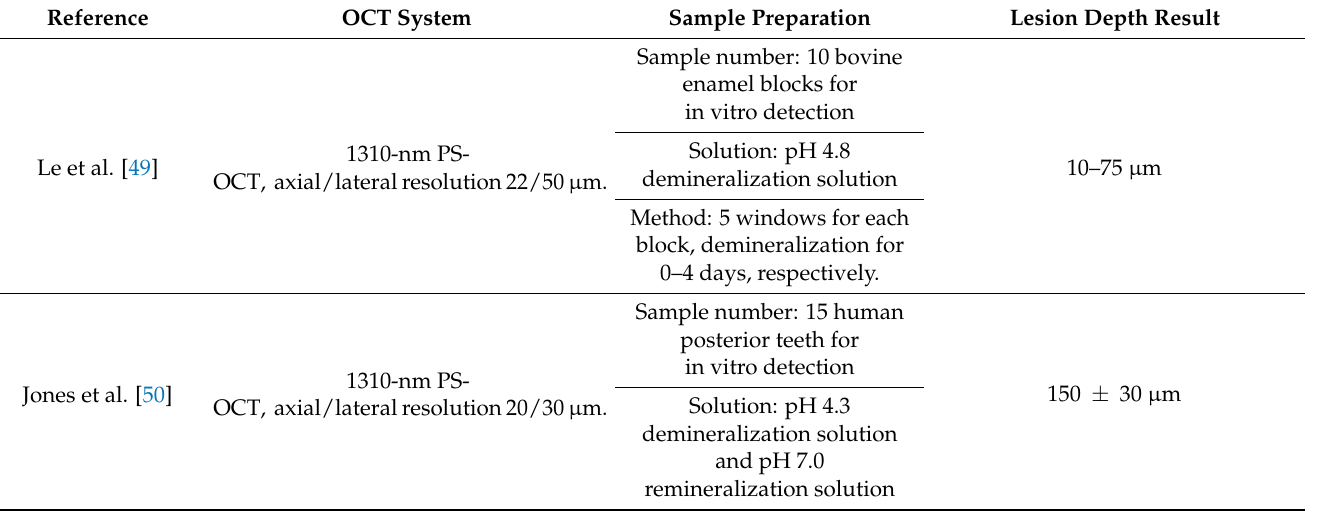
Table 1. Results of quantifying enamel caries with lesion depths.